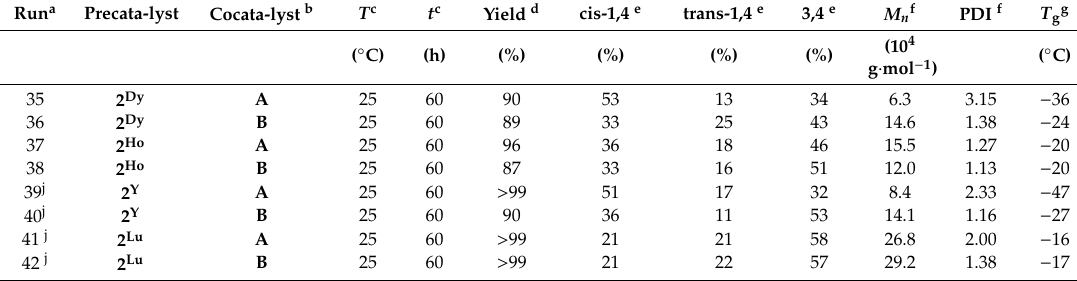
Figure 4. Ternary plot of the microstructures of the poly-1,3-butadienes ( a ) and polyisoprenes ( b ) obtained from of [Cp*LnMe 2 ] 3 ( 2 Ln ). Polymers produced applying cocatalyst A are represented by circles, those produced with cocatalyst B by squares. The metal centers of the precatalyst are color-coded as follows: orange (Dy), brown (Ho), cyan (Y), and grey (Lu). Data for the reactions applying the Y and Lu analogue precatalysts are shown for comparison [24]. Table 5. Isoprene homopolymerization by [Cp*LnMe 2 ] 3 ( 2 Ln